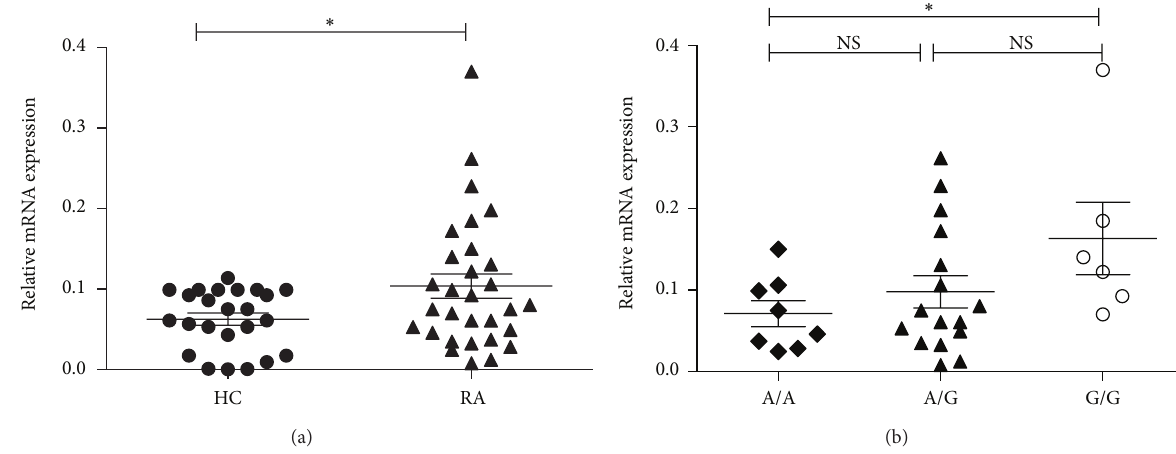
Figure 1: Analysis of PD-1 mRNA expression levels in RA patients with different genotypes of rs36084323. (a) Increased levels of PD-1 mRNA levels in PBMC of RA ( 𝑛 = 30 ) patients, as compared with those from healthy controls (HC) ( 𝑛 = 24 ) ( 𝑃 = 0.027 ). (b) The patients with GG genotype exhibited higher PD-1mRNA expression levels than those with AA genotype ( 𝑃 = 0.049 ). Horizontal bars indicate the mean ± SD, ∗ = 𝑃 < 0.05